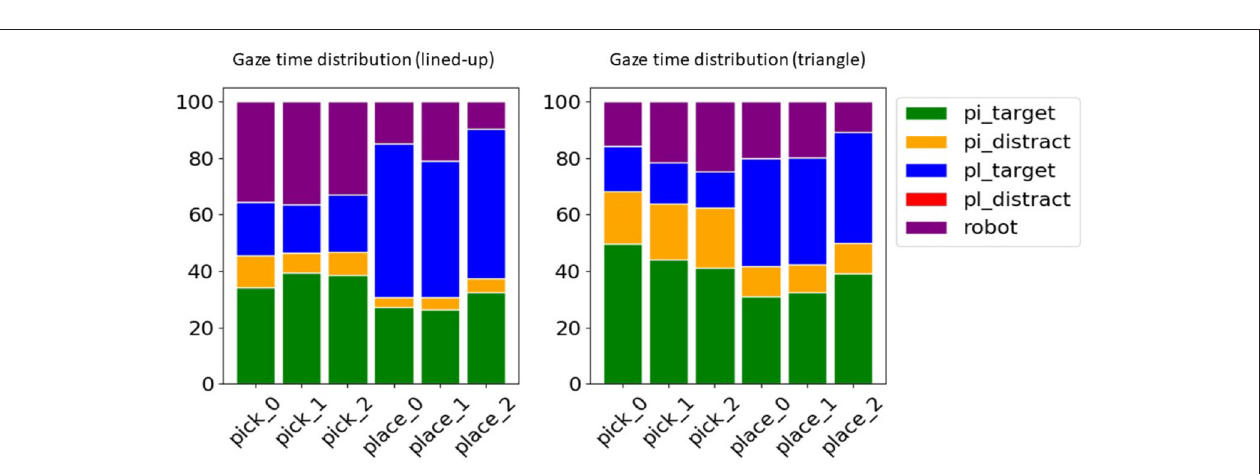
FIGURE 5 | Relative distribution of the time the gaze spent on semantic AoIs across tasks for the lined-up (left) and the triangle arrangement (right). In the pick tasks the respective picking AoIs (pi_target) are more looked at, in the place tasks the respective placing AoIs (pl_target). The other AOIs were summarized in the pick distractors (pi_distract, i.e., the cylinders not to be picked up), place distractors (pl_distract, i.e., possible place-down locations other than the target), and the robot hand